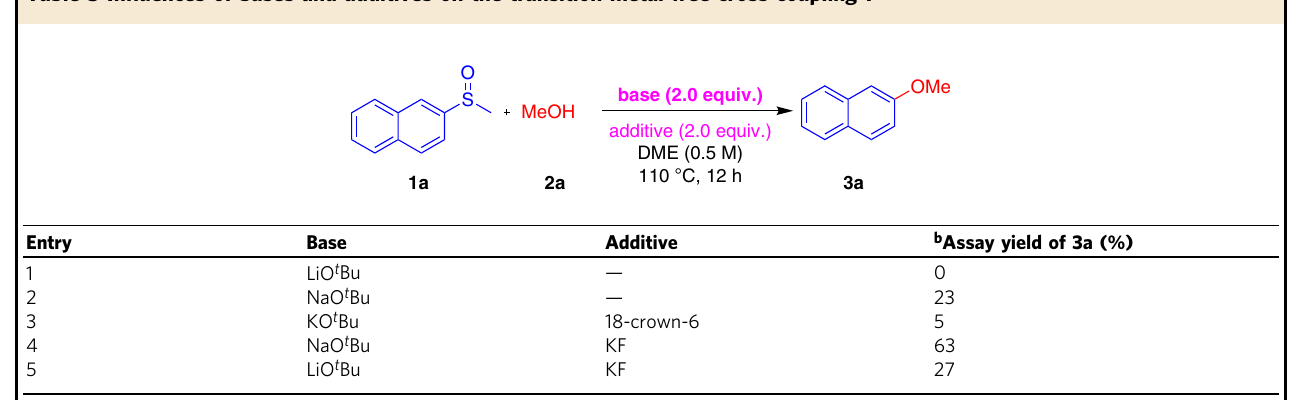
Table 3 In fl uences of bases and additives on the transition-metal-free cross-coupling a .